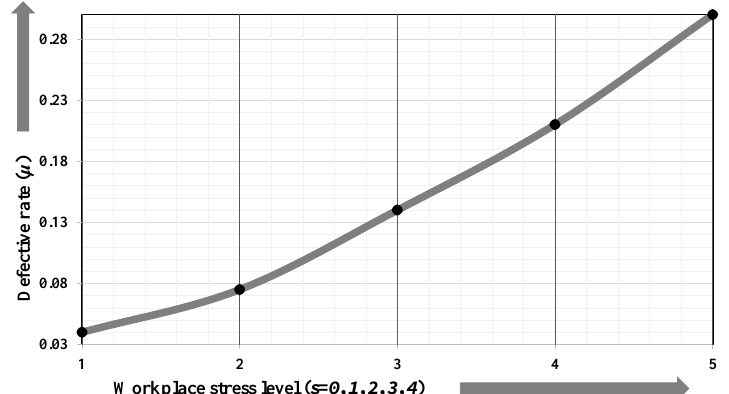
Figure 3. Relation between workers’ stress and defective